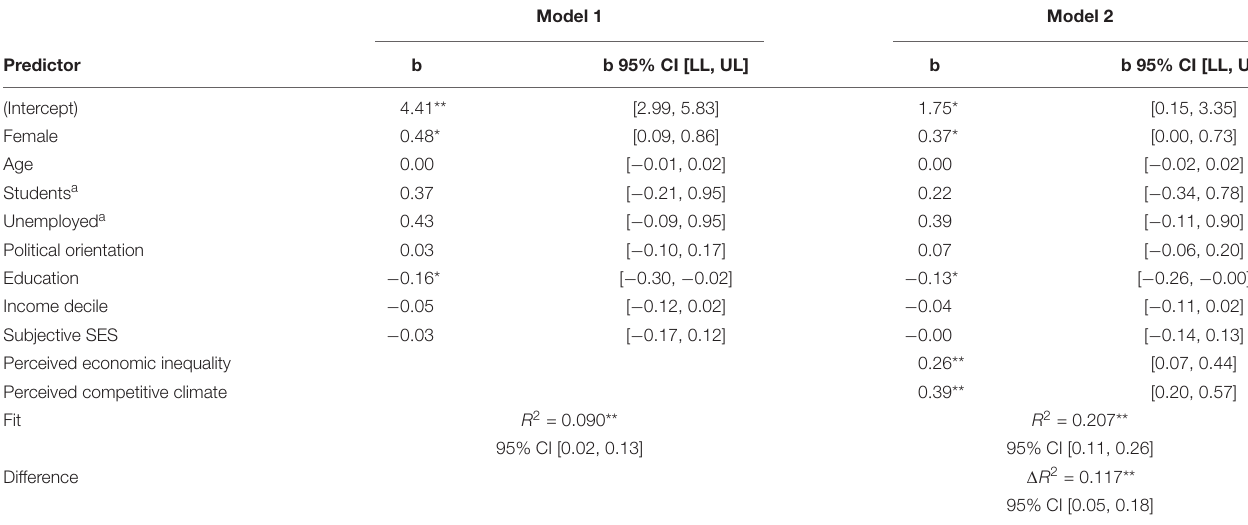
TABLE 1 | Regression analyses’ results using status anxiety as the